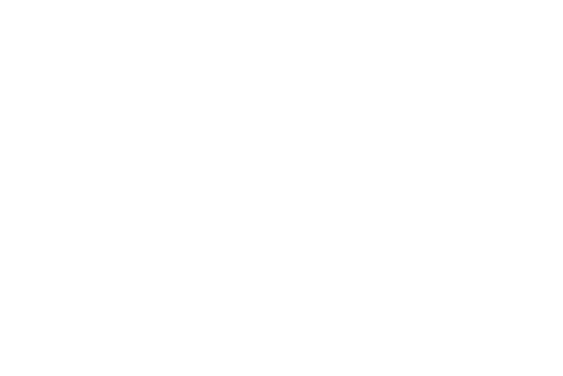
Table 1. Structural information on EuFeAs 2 7